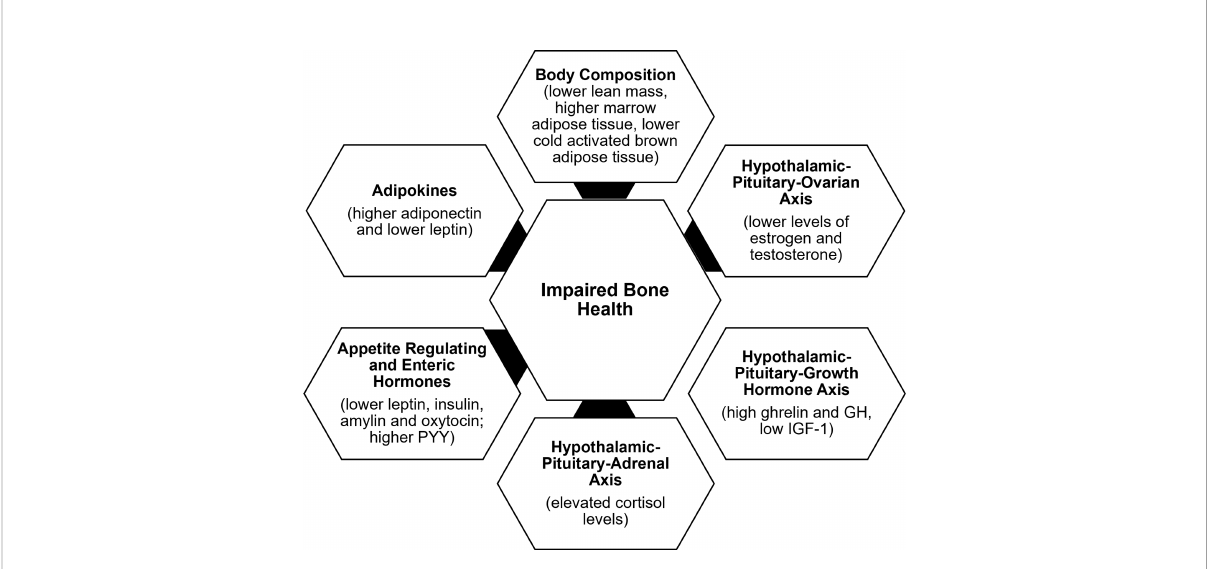
FIGURE 2 Factors contributing to impaired bone health in functional hypothalamic